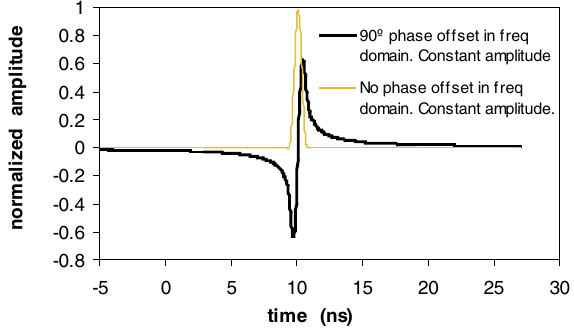
90º phase offset in freq domain. Constant amplitude No phase offset in freq domain. Constant amplitude.